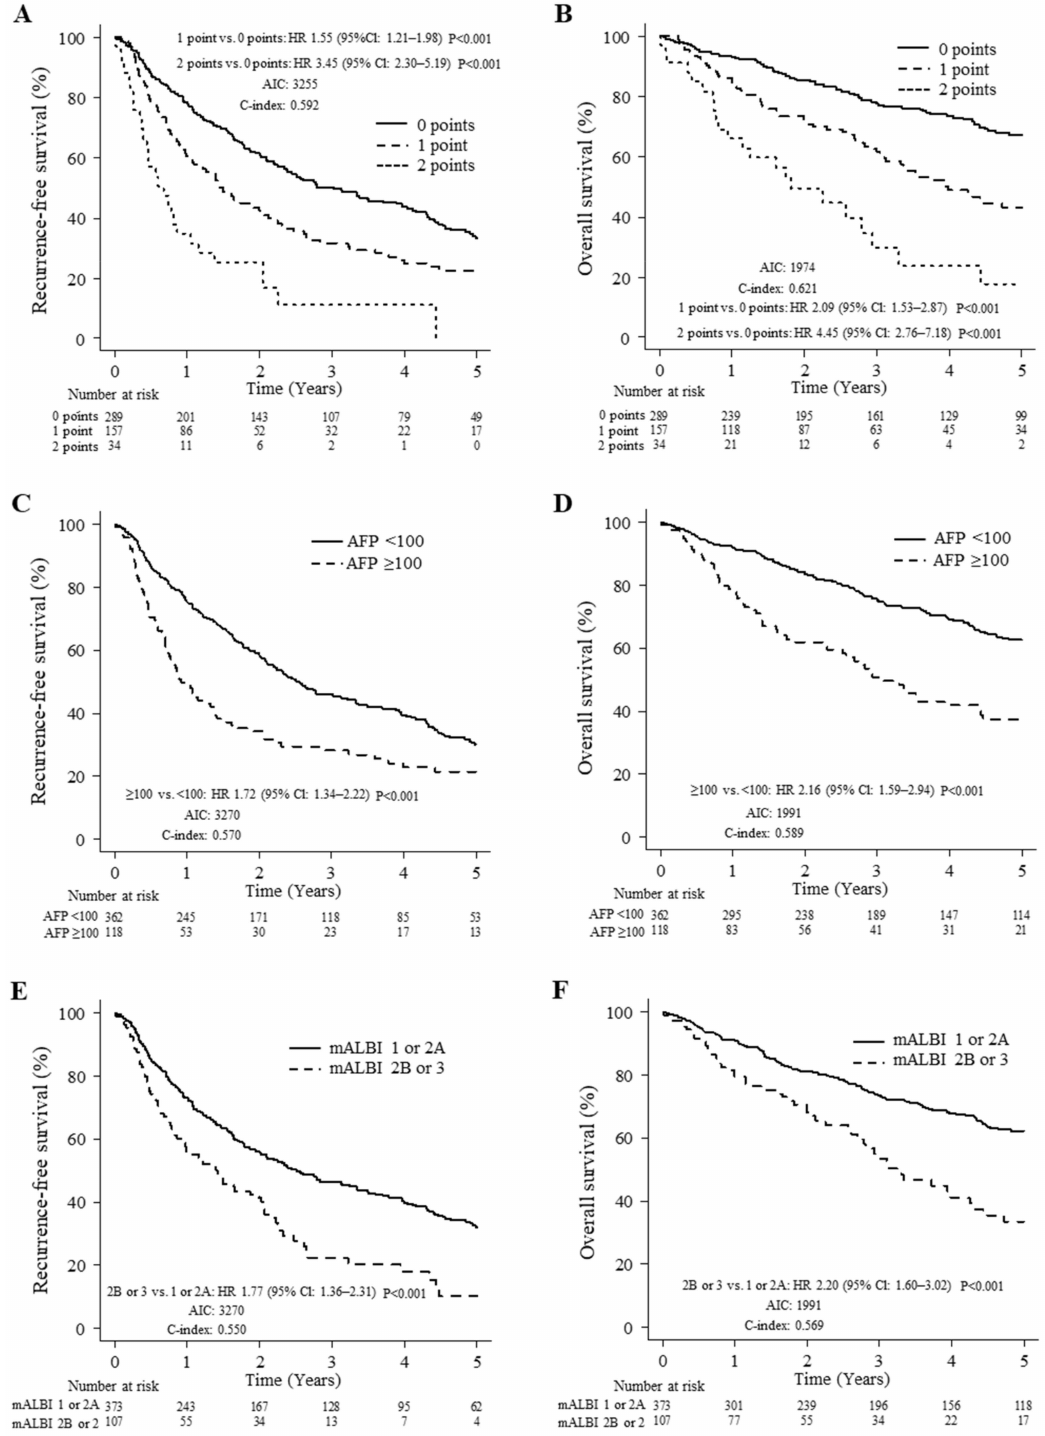
Figure 1. Comparison of mALF, AFP, and mALBI for prediction of recurrence-free survival (RFS) and overall survival (OS). ( A ) RFS in patients with mALF scores of 0, 1, and 2 points. ( B ) OS in patients with mALF scores of 0, 1, and 2 points. ( C ) RFS in patients with AFP <100 and ≥ 100 ng/mL. ( D ) OS in patients with AFP <100 and ≥ 100 ng/mL. ( E ) RFS in patients with mALBI 1 or 2A and 2B or 3. ( F ) OS in patients with mALBI 1 or 2A and 2B or